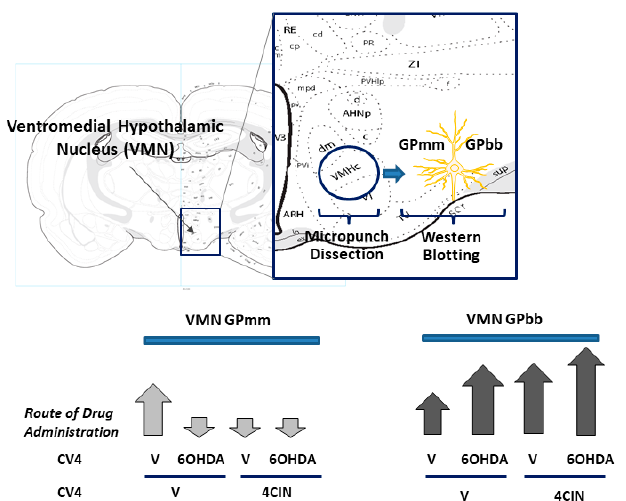
Figure 1. Differential hindbrain noradrenergic regulation of the ventromedial hypothalamic nucleus (VMN) glycogen phosphorylase brain (GPbb) versus muscle (GPmm) type protein expression. The coronal brain section illustration at the top depicts the location of the VMN within the mediobasal hypothalamus; that area is enlarged in the blue rectangle to show micropunch tool positioning for the collection of VMN tissue for the Western blot analysis of GPmm and GPbb proteins. The hollow circular punch tool was centered on the longitudinal axis of the VMN to ac ‐ quire tissue from dorsomedial (dm), central (c) and ventrolateral regions of this nucleus. In the brain, GP proteins are expressed primarily in astrocytes but neurons also contain GPbb, albeit at relatively lower levels. Male rats were pretreated by the administration of vehicle (V) or the cate ‐ cholamine neurotoxin 6 ‐ hydroxydopamine (6OHDA) into the caudal fourth ventricle (CV4) prior to the delivery of the monocarboxylate transporter inhibitor 4 ‐ alpha ‐ cyano ‐ cinnamic acid (4CIN). At the bottom, the arrows indicate the direction of various treatment effects on GPmm (left) and GPbb (right) expression relative to V ‐ treated controls. It should be noted that outcomes documenting lactoprivic augmentation of the gluco ‐ inhibitory transmitter GABA likely reflect, to some extent, differences associated with this experimental model (which involves selective pharmacological activation of a single met ‐ abolic ‐ sensory cell population, e.g., hindbrain A2 neurons) compared with systemic insu ‐ lin ‐ induced hypoglycemia (which is characterized by body ‐ wide sensor activation). It is possible that under the latter circumstances, noradrenergic stimulation of GAD expres ‐ sion may be attenuated by a neurotransmitter cue(s), as ‐ yet ‐ unidentified, that is provided to the VMN by non ‐ hindbrain energy sensors. Alternatively, up ‐ regulated GABA trans ‐ mission may be a signal of glycogen conservation due to negligible disassembly caused by down ‐ regulated expression of NE ‐ sensitive GPbb, alongside an absence of metabolic deficit activation of GPbb activity. These findings are consistent with earlier reports that NE depletion reduces glycogenolysis during energy imbalance [53]. 8. NE Signaling Appraises the VMN of Hindbrain Glycogen Metabolic Status In light of proof that ample tissue glycogen levels are maintained in the brainstem [54], it was relevant to examine the premise that hindbrain glycogen ‐ derived fuel supply affects A2 energy stability and the governance of VMN metabolic transmitter signaling and glycogen metabolism [55]. Rats treated by DAB administration to the caudal fourth ventricle exhibited exogenous lactate ‐ revocable changes in laser ‐ catapult microdissected metabolic ‐ sensory A2 noradrenergic neuron AMPK expression and VMN NE content. The ability of lactate to prevent DAB suppression of A2 nerve cell estrogen receptor ‐ alpha (ER α ) and G ‐ protein ‐ coupled estrogen receptor ‐ 1 (GPER) protein content advances the novel notion that glycogen ‐ derived energy fuel supply may control estradiol input to